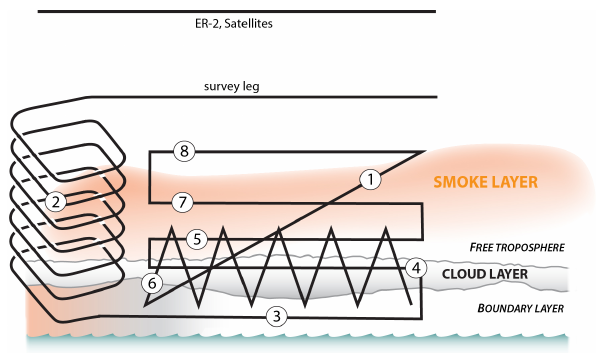
Figure 12. Schematic of flight maneuvers during research flight linked to descriptions in Table 2 and flight synopses in Tables A1–